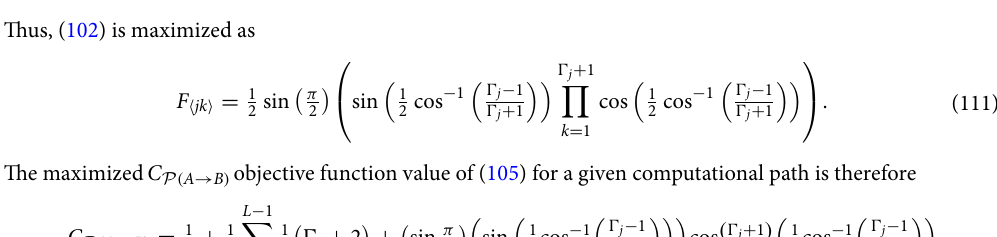
in function of gate parameters β j and γ j j 1, . . . , Ŵ j = 8 =